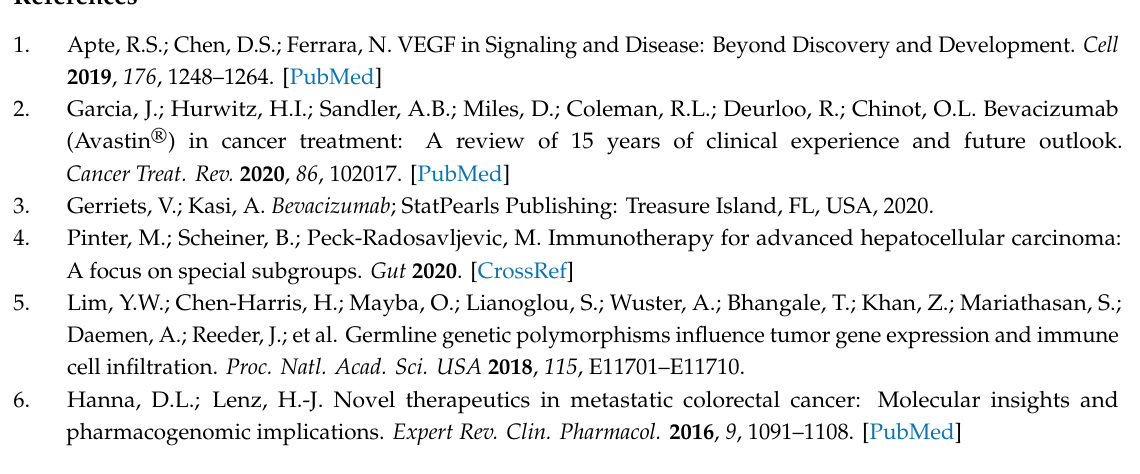
Table S1: Univariate analysis for the 13 SNPs according to PFS; Table S2: Univariate analysis for clinico-pathological features according to PFS; Table S3: Univariate analysis for the 13 SNPs according to OS; Table S4: Univariate analysis for clinico-pathological features according to OS; Table S5: Summary of genotyping results by MassARRAY (AGENA) of 306 patients; Figure S1: E ff ect of significant clinical characteristics and polymorphisms according to PFS; Figure S2: E ff ect of subtype and histological grade combination according to PFS; Figure S3: E ff ect of significant clinical characteristics and polymorphisms according to OS; Figure S4: E ff ect of subtype and histological grade combination according to